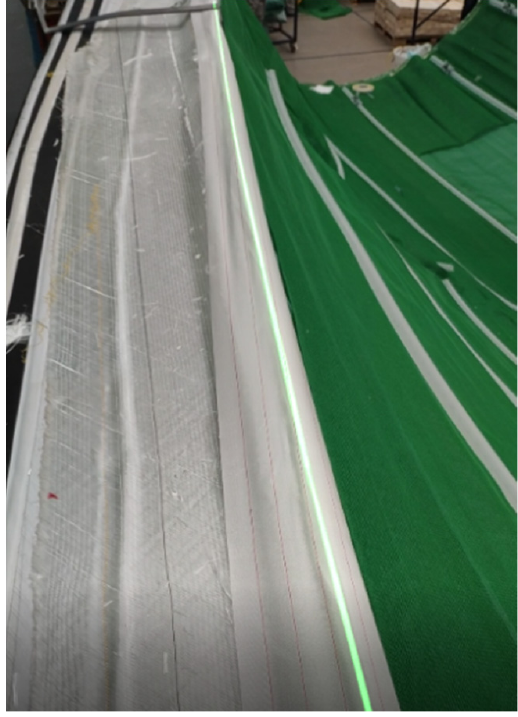
Figure 14. Autocorrected 0~16 m target points.